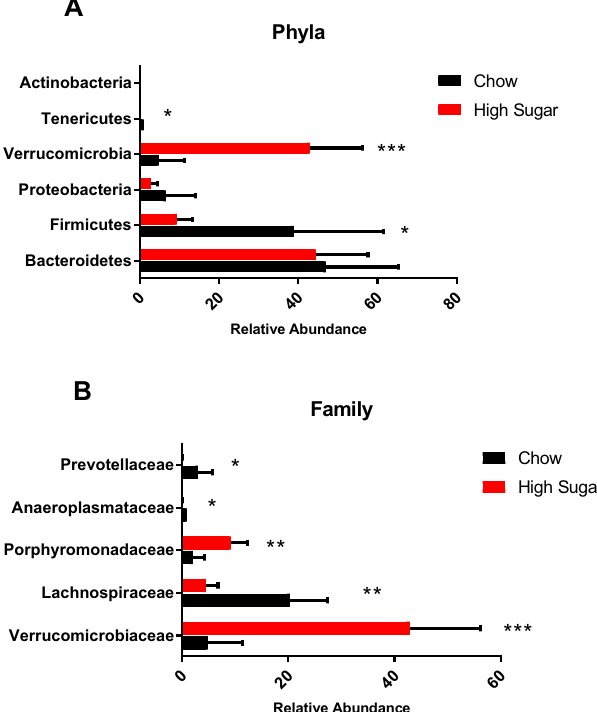
Figure 7. Effects of high-sugar diet on microbiota at the phyla and family levels. At the Phyla level, Verrucomicrobia was elevated in high sugar fed mice (p < 0.01, FDR < 0.01), while Firmicutes and Tenericutes were depleted (p = 0.02, FDR < 0.04) ( A ). At the family level, Lachnospiraceae, Prevotellaceae, and Anaeroplasmataceae were significantly decreased by a high-sugar diet (p < 0.01, FDR < 0.02) while Verrucomicrobiaceae and Porphyromonadaceae were significantly elevated (p < 0.01, FDR < 0.02) ( B ). Data is shown as mean ± SEM of relative abundance. Chow: n = 5; HS: n =